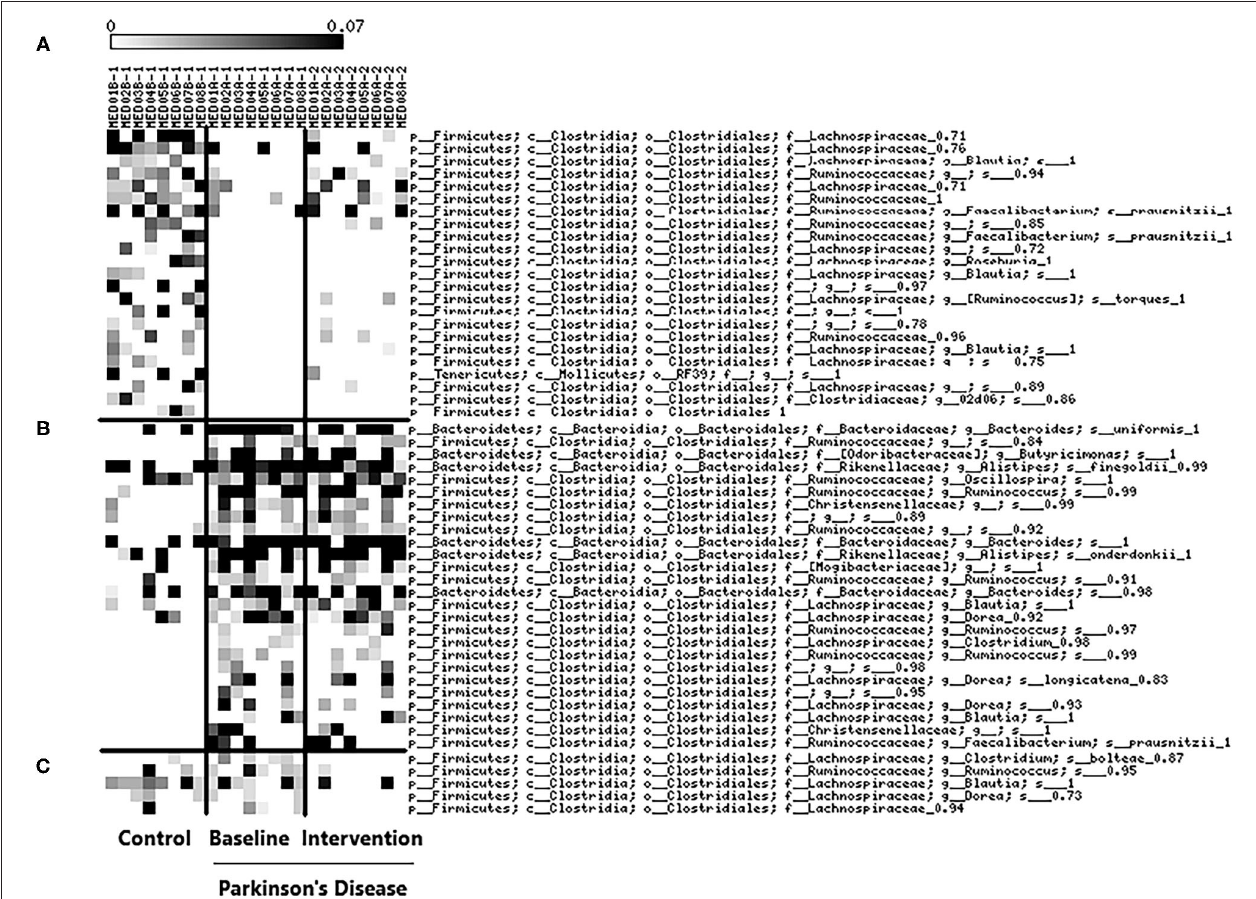
FIGURE 1 | Heat-map of prevalent bacterial OTUs (determined by z-score) with 95% similarity at baseline between control ( n = 8) and PD groups ( n = 8) and changes after a 5-week Mediterranean diet intervention (PD group; n = 8). (A) OTUs that were more prevalent in the control group compared to PD group at baseline. (B) OTUs that were more prevalent in the PD group compared to control group at baseline. (C) OTUs that decreased after the Mediterranean diet intervention in the PD